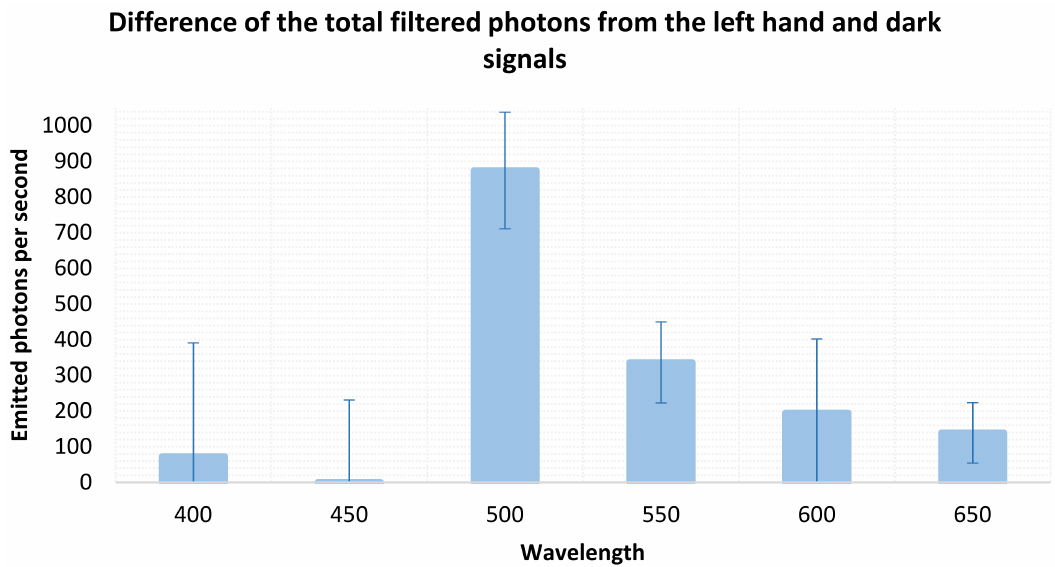
Figure 4. Total filtered FVB readings (photons emitted at the collecting conditions every second) after subtracting the subject’s left hand and dark signal at several wavelengths. Every wavelength was measured for 10